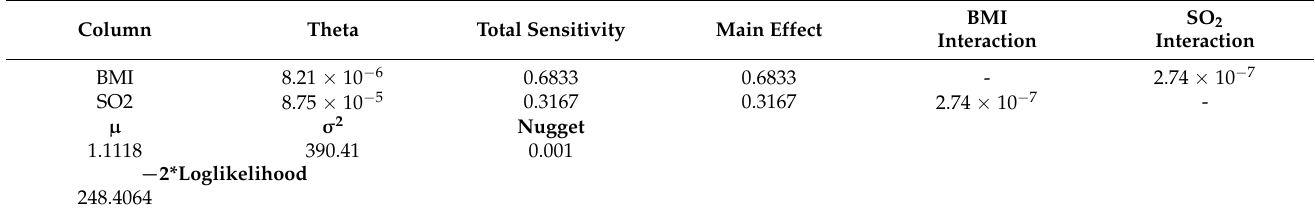
Table 4. Gaussian process model of %LAA-950insp-based COPD-E severity and progression: BMI, and SO 2 .